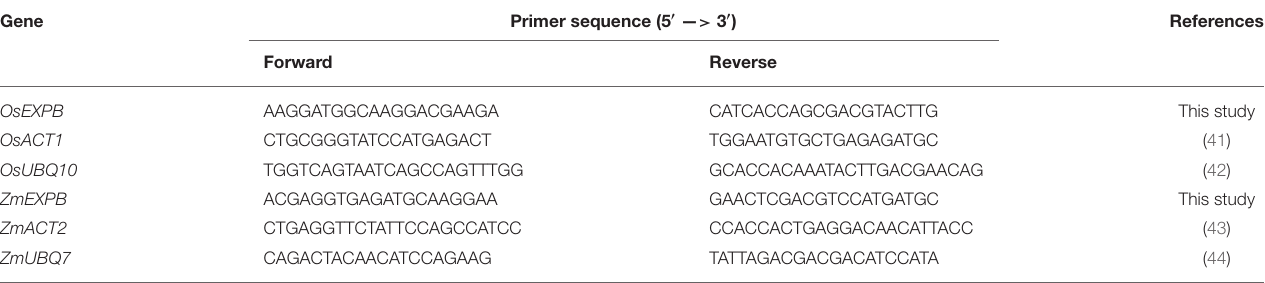
TABLE 1 | Primer sequences for either β -expansin or reference genes of rice and maize. Gene Primer sequence (5 ′ — > 3 ′